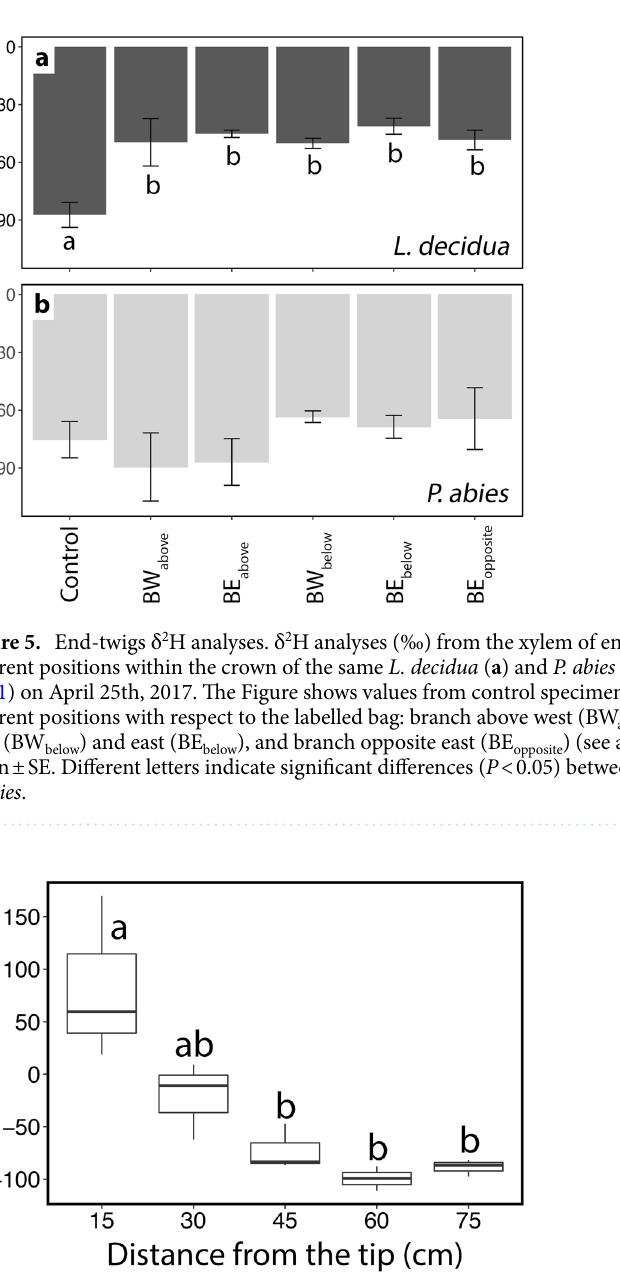
Figure 6. Branch water uptake. δ 2 H values (‰) measured on microcores extracted along four branches (every ca. 15 cm) of P. abies after 2 weeks of labelling. The point at 15 cm was submersed inside the bag, while points at 30, 45 and 60 cm were outside the bag. The point at 75 cm corresponds to the microcores collected at the trunk (see Fig. 1b). Boxplots show the median, the 25th and 75th percentiles and the whiskers show minimum and maximum values. Different letters indicate significant differences ( P < 0.05) between